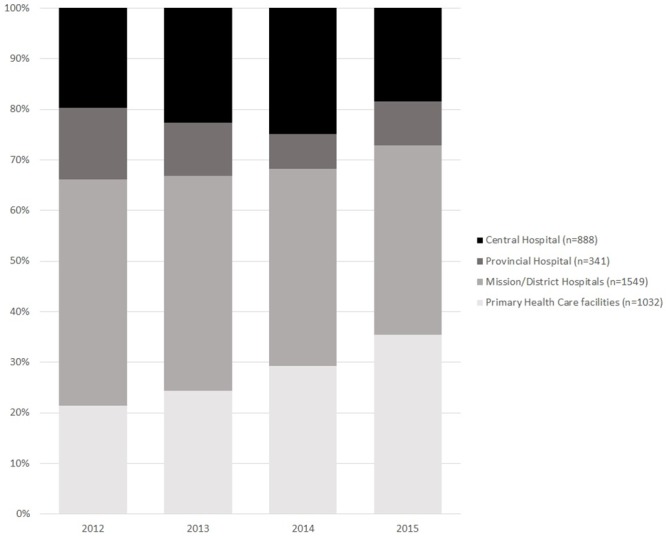
Level of care where the 3,810 patients started ART between 2012–2015, in Zimbabwe.